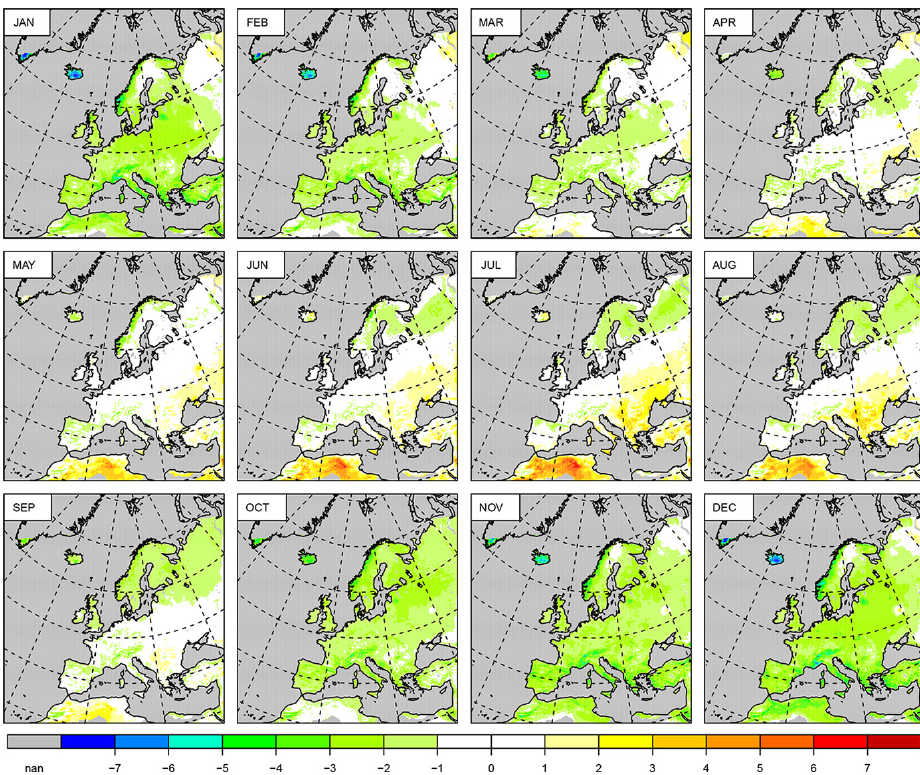
Figure 3. Mean di ff erences of monthly mean 2m air temperatures [K] from 1950 to 2012: coastDat2-CCLM minus